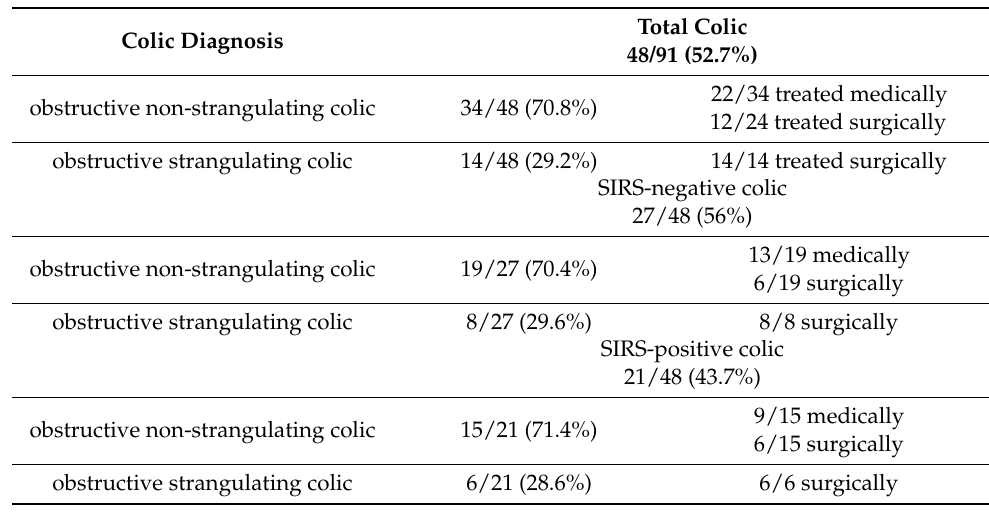
Table 1. Results concerning the diagnosis (grouped as non-strangulating or strangulating colic) and treatment of the total of colic horses, the SIRS-negative colic horses and the SIRS-positive colic horses enrolled in the study.